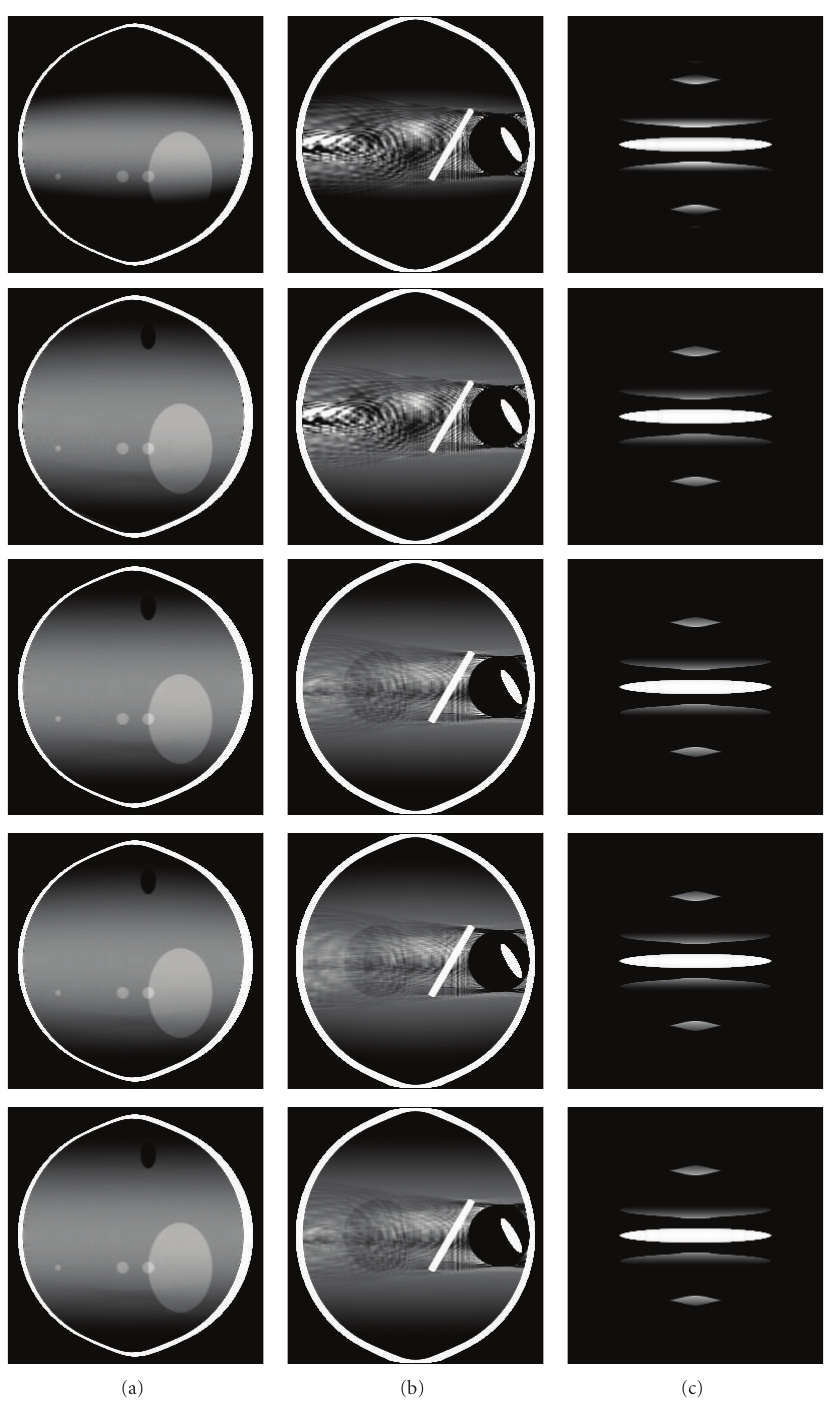
Figure 7: From left to right column, reconstructed slices of Shepp-Logan low contrast, ForBild head and Defrise disk phantom, respectively, at x = 0. From top row to bottom row, reconstruction with FDK algorithm, Hu’s algorithm, T-FDK algorithm, CFDKW-1, and CFDKW- 2 respectively. Display windows are [0 . 98 1 . 05], [1 . 01 1 . 09] and [0 . 5 0 . 7] for Shepp-Logan, ForBild head and Defrise disk phantom,